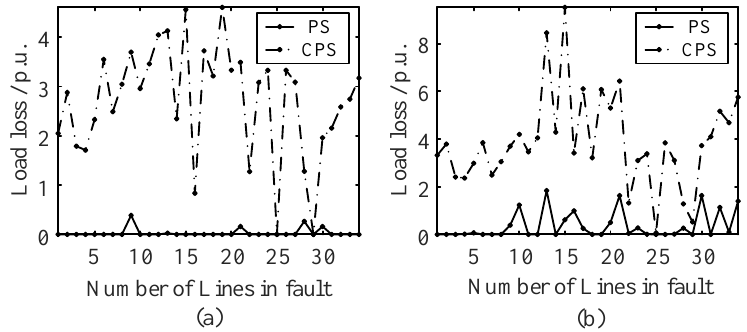
Figure 9. Comparison of risk consequences of random grounding fault in a CPS and a PS: ( a ) line 14–16 is connected; and ( b ) line 14–16 is disconnected.